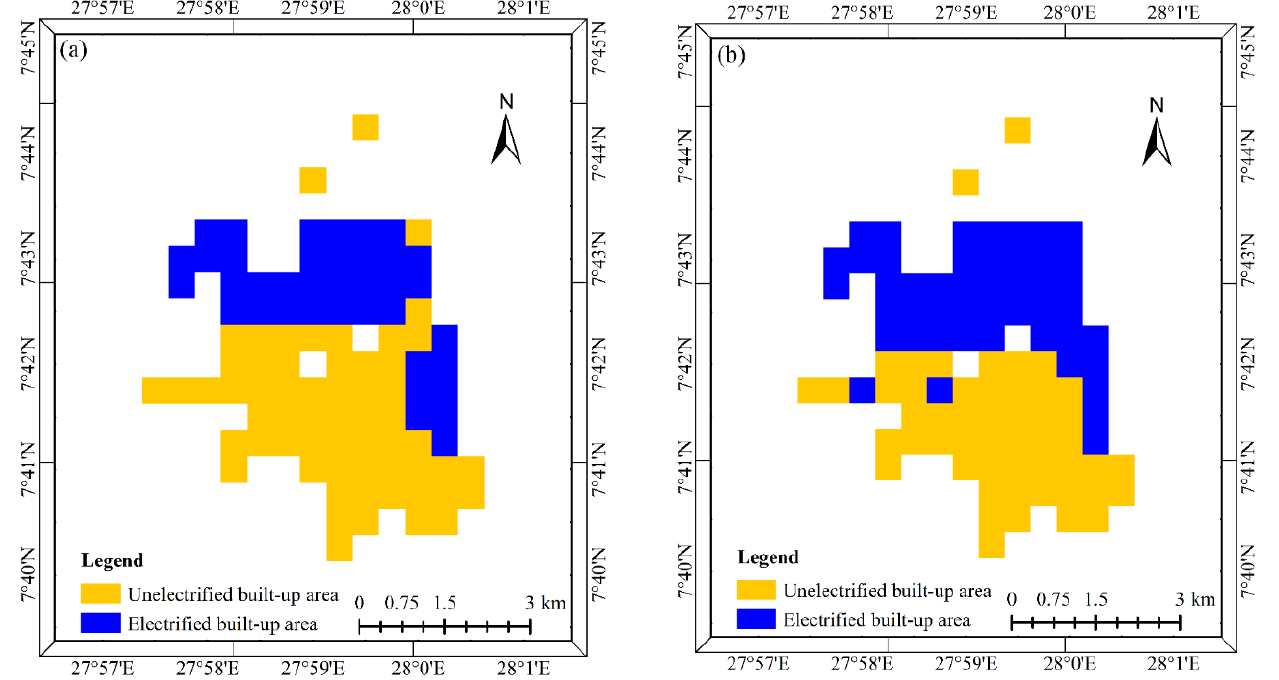
Figure 3. Electrified and non-electrified built-up areas in Wau, South Sudan, in 2014 ( a ) and 2020